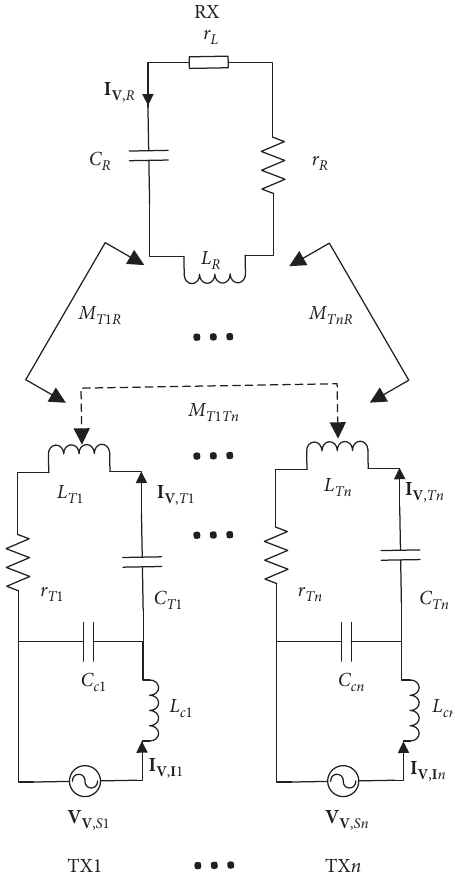
Figure 5: Circuit topology of voltage-optimized circuit scheme of multiple-TX WPT